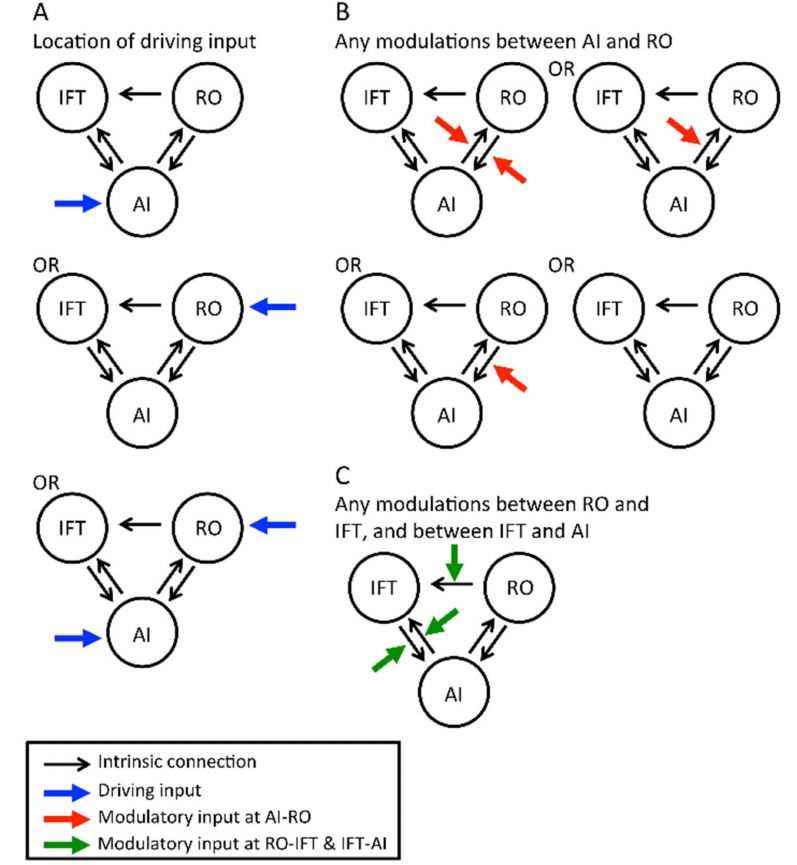
Figure 3. Composition of dynamic causal modelling (DCM) models. ( A ) Three possible options of sensory inputs (blue arrows), from the anterior insula (AI), rolandic operculum (RO), or both. ( B ) For each scenario of sensory input, there were four possible options of neural modulation by taste and smell signals (red arrows) of intrinsic connections between AI and RO. Therefore, there existed 12 groups of models (3 × 4), or in DCM terminology, 12 families. These 12 families were compared against each other. ( C ) In each family, there were eight models, representing any of the combinations of neural modulation at other sites (green arrows) which may either be present or absent (that is, there were two possibilities between RO and IFT, and four possibilities between AI and IFT). For how these intrinsic connections, driving input, and modulatory inputs were chosen based on existing literature, please see main text “Definition of driving inputs, Definition of modulatory inputs, and Inference on model structure using BMS” and Table